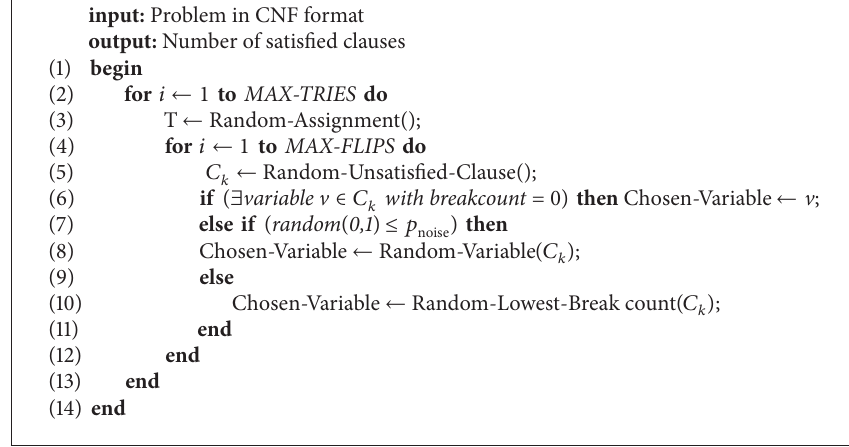
Algorithm 1: Walksat